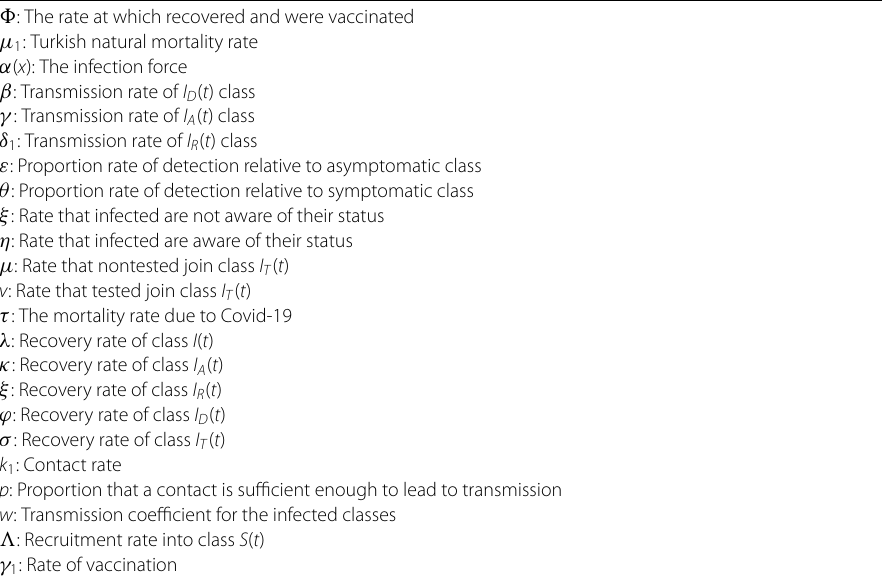
Table 6 Parameters of the suggested Covid-19